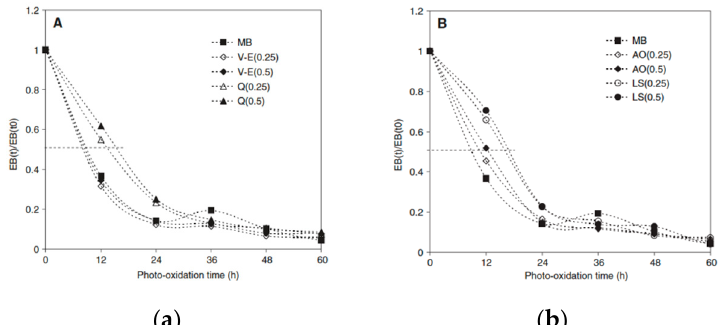
Figure 14. Dimensionless elongation at break, EB (t) / EB (t0) , of the starch-based biodegradable film (Mater-Bi ® ), additivated with ( a ) vitamin E (V-E) and quercetin (Q) and ( b ) synthetic antioxidant (AO) and light stabilizer (LS) [79], Reproduced with permission from Dintcheva NTz, J. Polym. Eng.; published by De Gruyter, 2014.